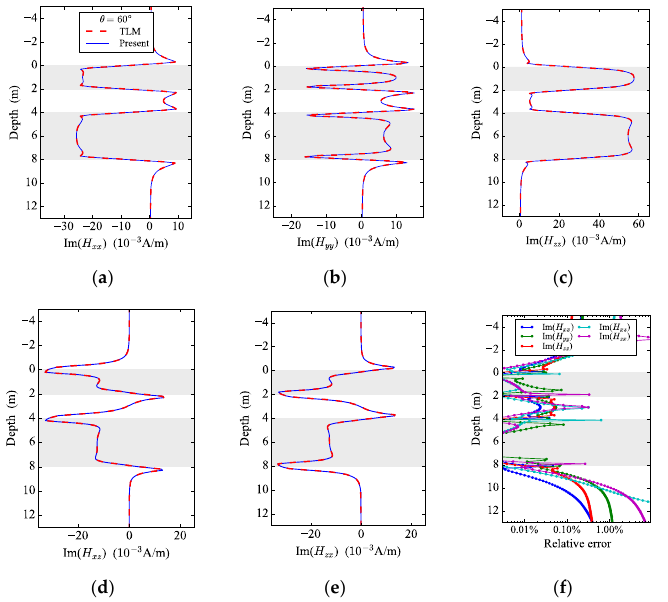
Figure 11. Responses of the tool in the layered model with diag(20,20,2) S/m  σ simulated by the TLM and present method. ( a ) Im( ) xx H . ( b ) Im( ) yy H . ( c ) Im( ) zz H . ( d ) Im( ) xz H . ( e ) Im( ) zx H . ( f ). Relative error. the TLM and present method. ( a ) Im ( H xx ) . ( b ) Im ( H yy ) . ( c ) Im ( H zz ) . ( d ) Im ( H xz ) . ( e ) Im ( H zx ) . ( f ). Relative